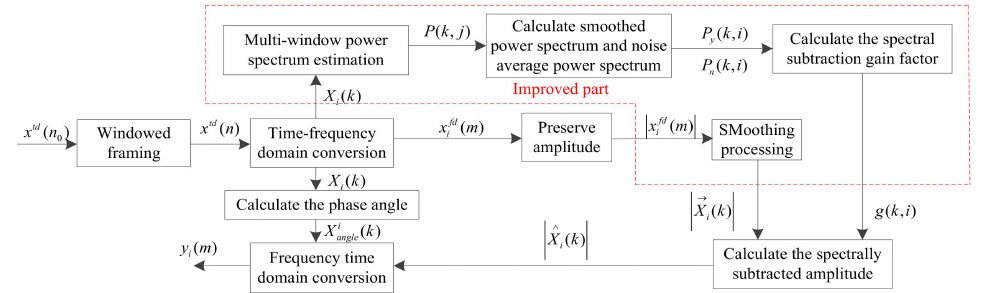
Figure 3. Improved spectral